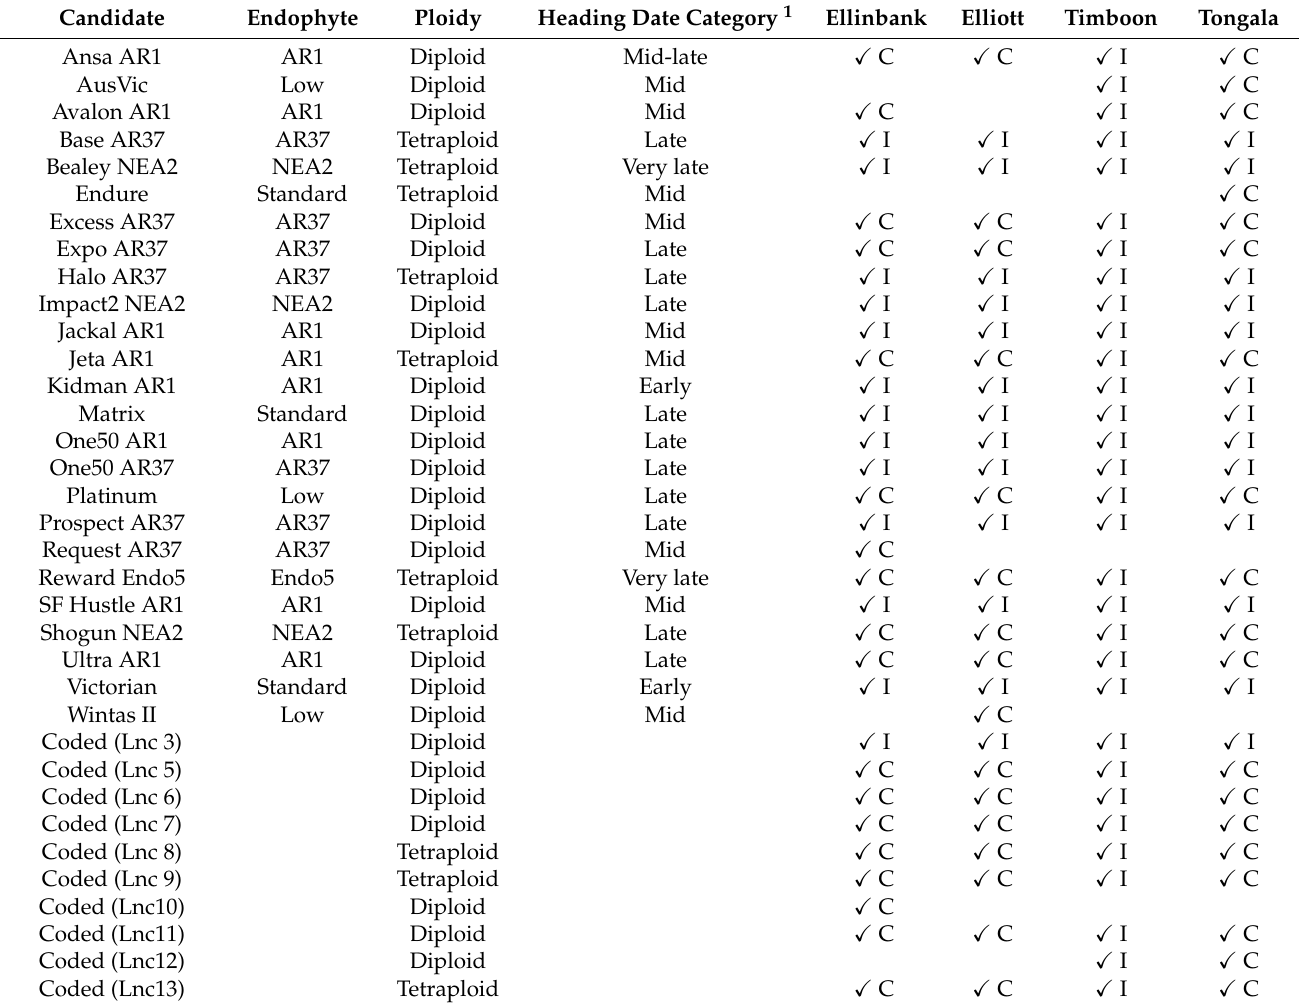
Table A1. Summary details of candidates sown ( (cid:88) ) in each of the 4 trial sites including